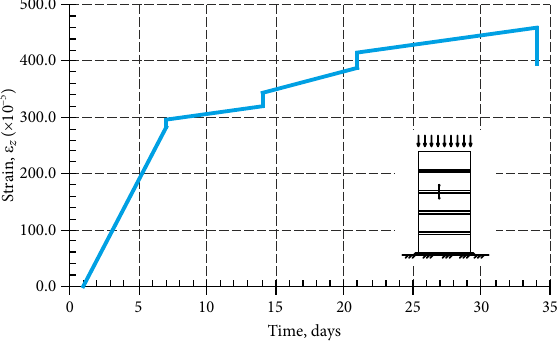
Fig. 11. The dependence of the relative longitudinal deformations of bed joint of masonry fragment compressed with the changing load over the time